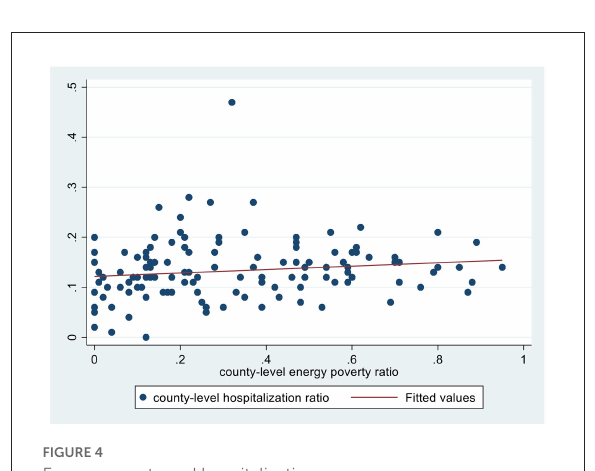
FIGURE4 Energy poverty and hospitalization.